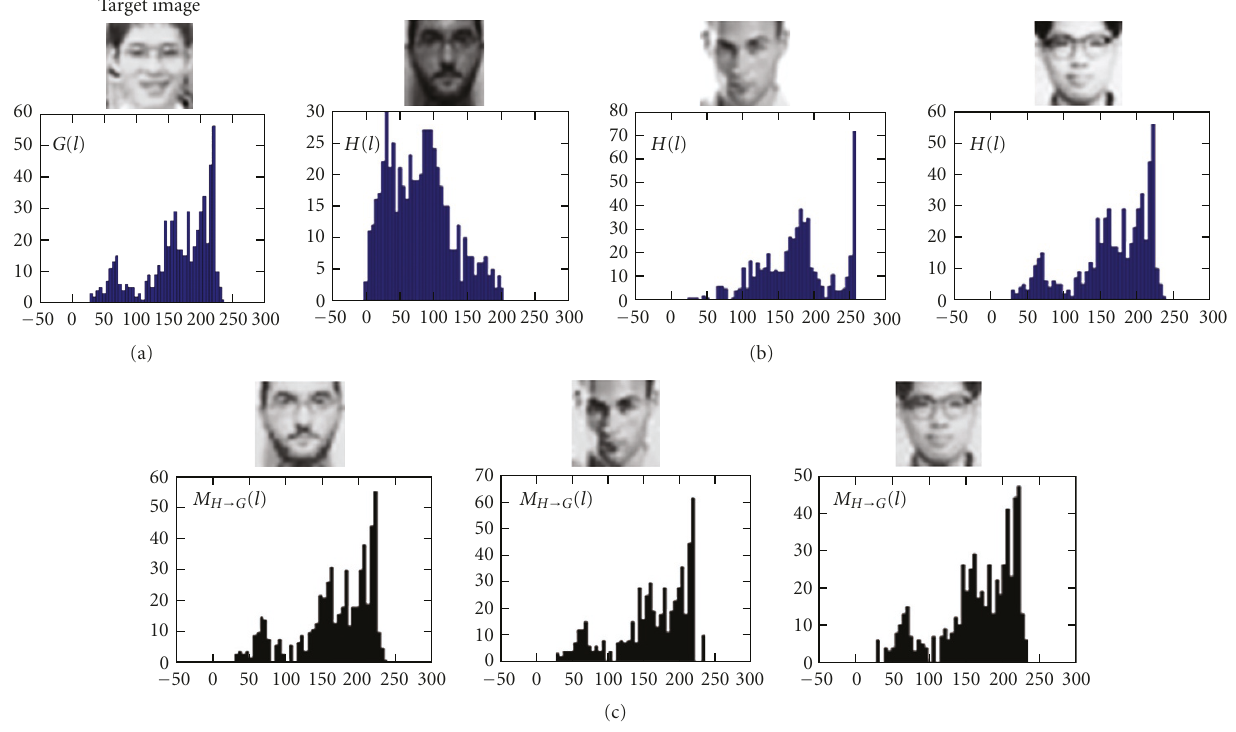
Figure 4: Lighting normalization. (a) Target image, (b) Input images, (c) Lighting normalized images.